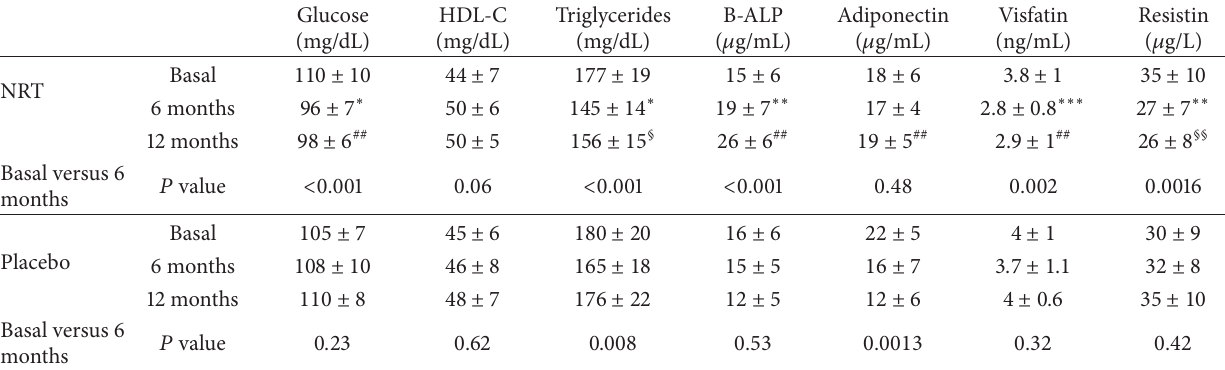
Table 2: Biomarkers evaluation through the study (mean ±